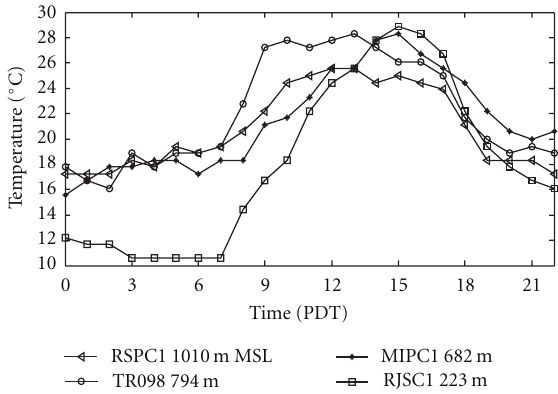
Figure 3: 60min average temperatures recorded at nearby RAWS sites during the day of the burn. The relative locations of the RAWS stations are shown in Figure